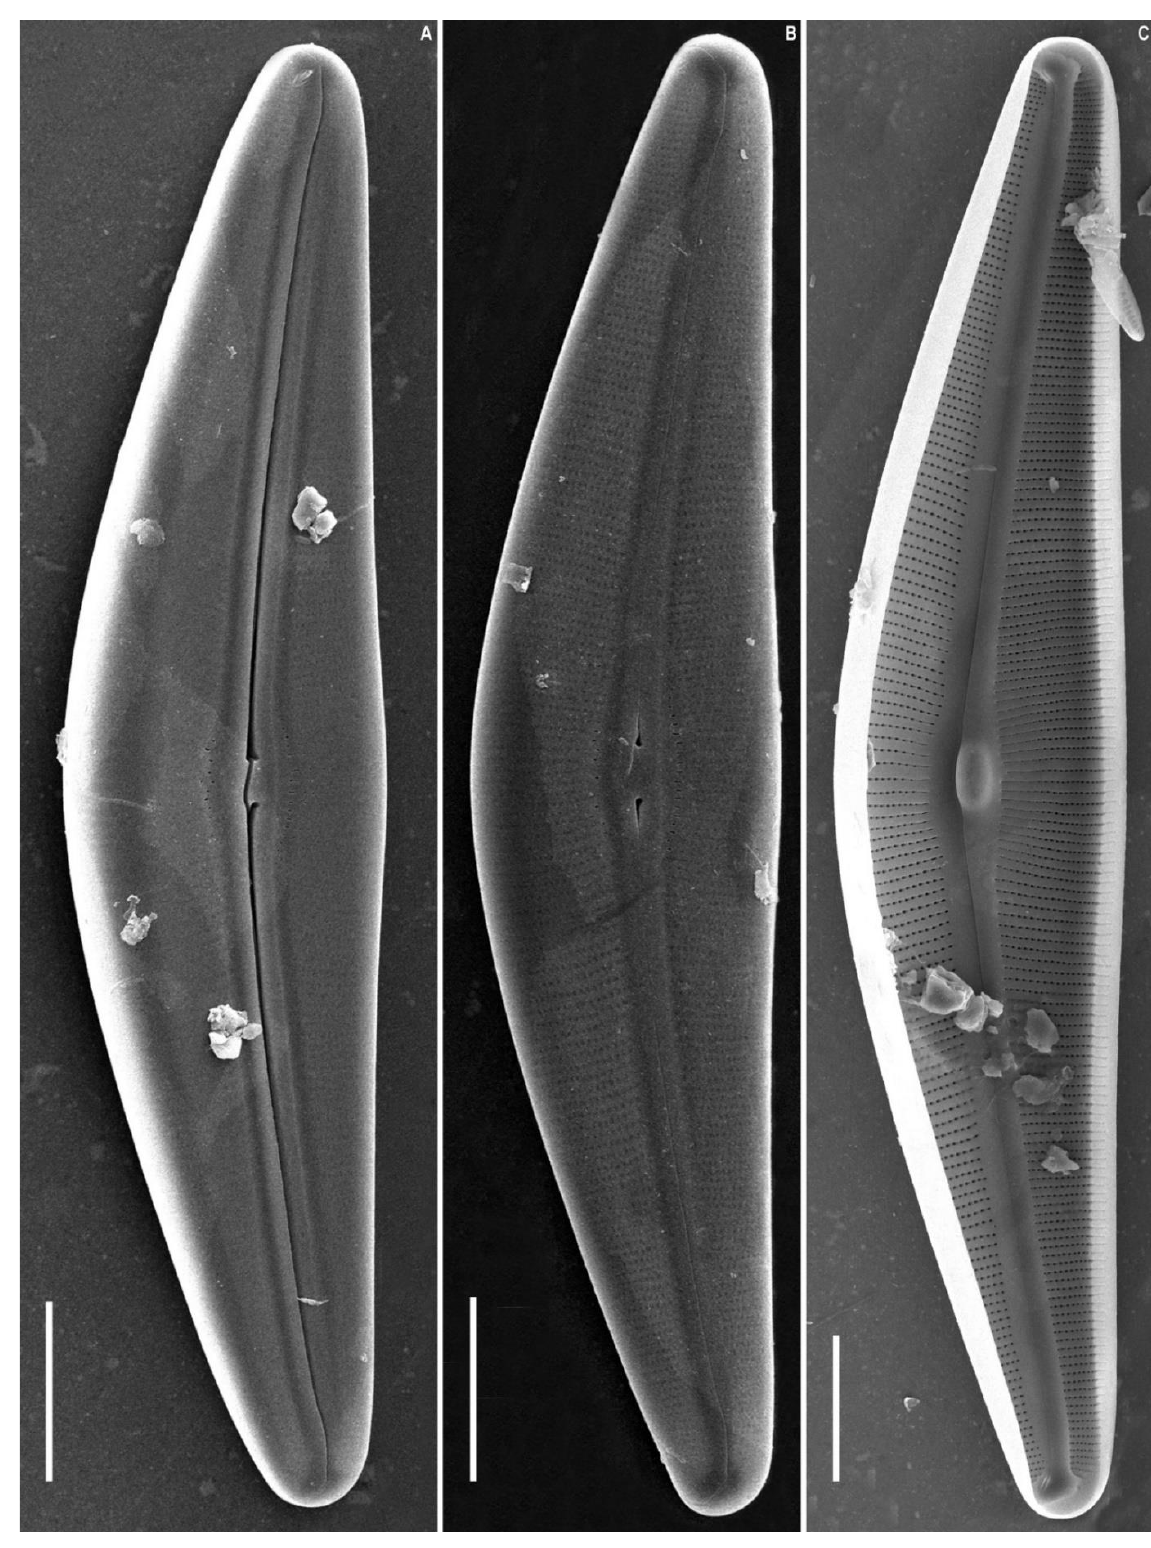
Figure 3. Cymbella himalaspera Jüttner and Van de Vijver in Jüttner et al. 2010. Strain B271. Scanning electron microscopy. ( A , B ) External views . ( C ) Internal view. Scale bars ( A , B ) = 25 μm; ( C ) = 20 μm. SEM, external view (Figures 3A,B and 4A – C). The slit of the raphe is located on a raised rib. Proximal raphe endings are slightly expanded, drop-shaped, and unilaterally deflected towards the ventral margin. The raphe towards the ends is weakly undulate,